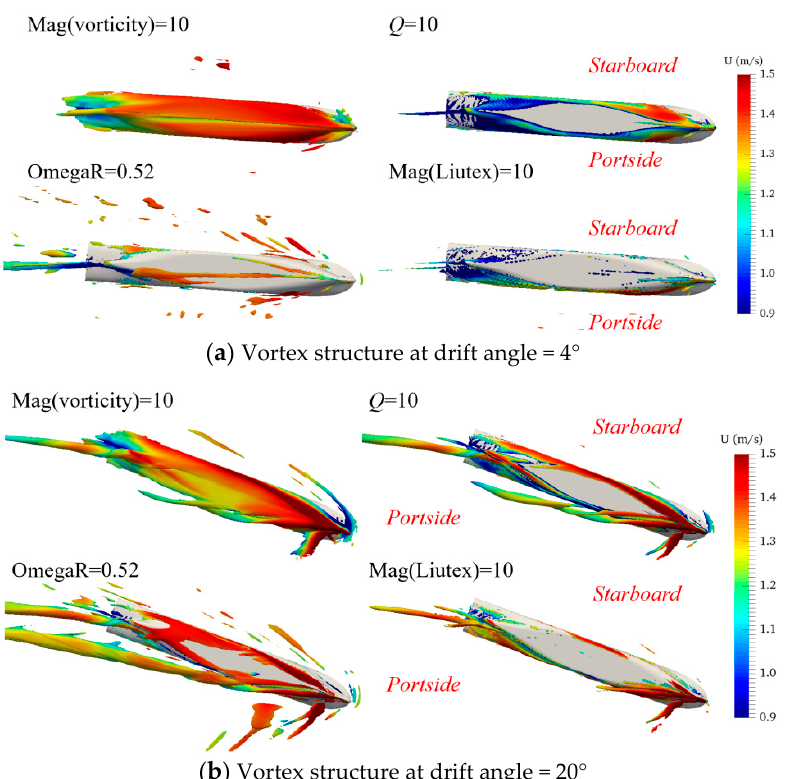
Figure 8. Vortex structure in the simulations of the static drift test: ( a ) vortex structure in CASE DA4; ( b ) vortex structure in CASE DA20.